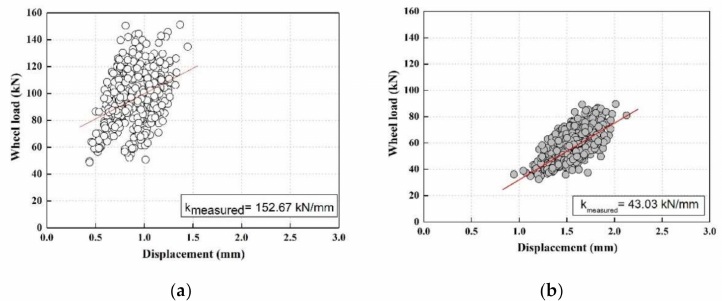
Figure 3. Track support sti ff ness (TSS) comparison of ballasted and ballast-less slab tracks: ( a ) TSS of the evaluated ballasted track, and ( b ) TSS of the evaluated ballast-less slab track